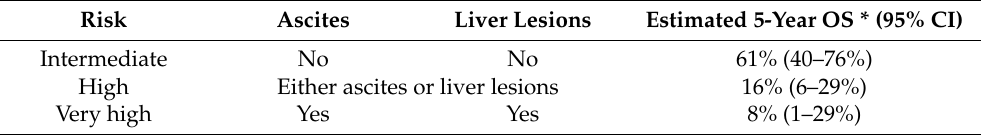
Table 2. Memorial Sloan Kettering Cancer Center image-based risk